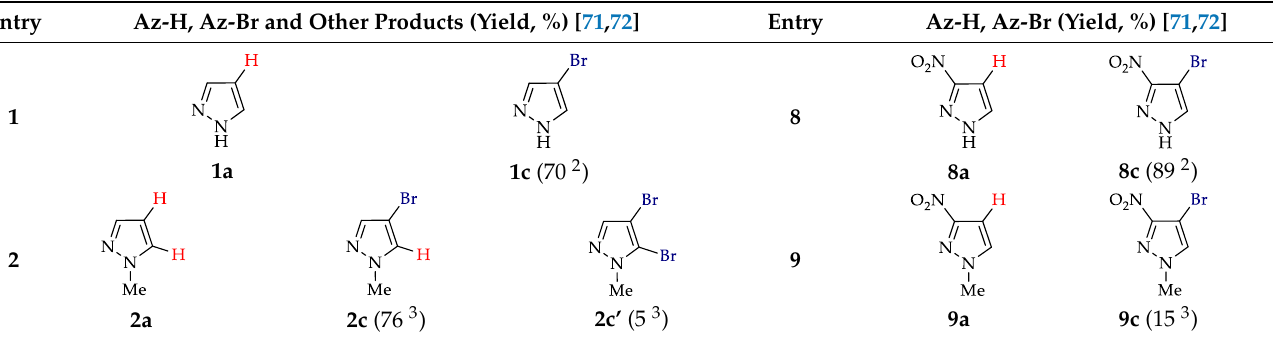
Table 2. C-H An bromination of pyrazoles (Az-H) 1 . Table 2. C‒H An bromination of pyrazoles (Az‒H) 1 . Table 2. C‒H An bromination of pyrazoles (Az‒H) 1 . Table 2. C‒H An bromination of pyrazoles (Az‒H) 1 . Table 2. C‒H An bromination of pyrazoles (Az‒H) 1 . Table 2. C‒H An bromination of pyrazoles (Az‒H) 1 . Table 2. C‒H An bromination of pyrazoles (Az‒H) 1 . Table 2. C‒H An bromination of pyrazoles (Az‒H) 1 . Table 2. C‒H An bromination of pyrazoles (Az‒H) 1 . Table 2. C‒H An bromination of pyrazoles (Az‒H) 1